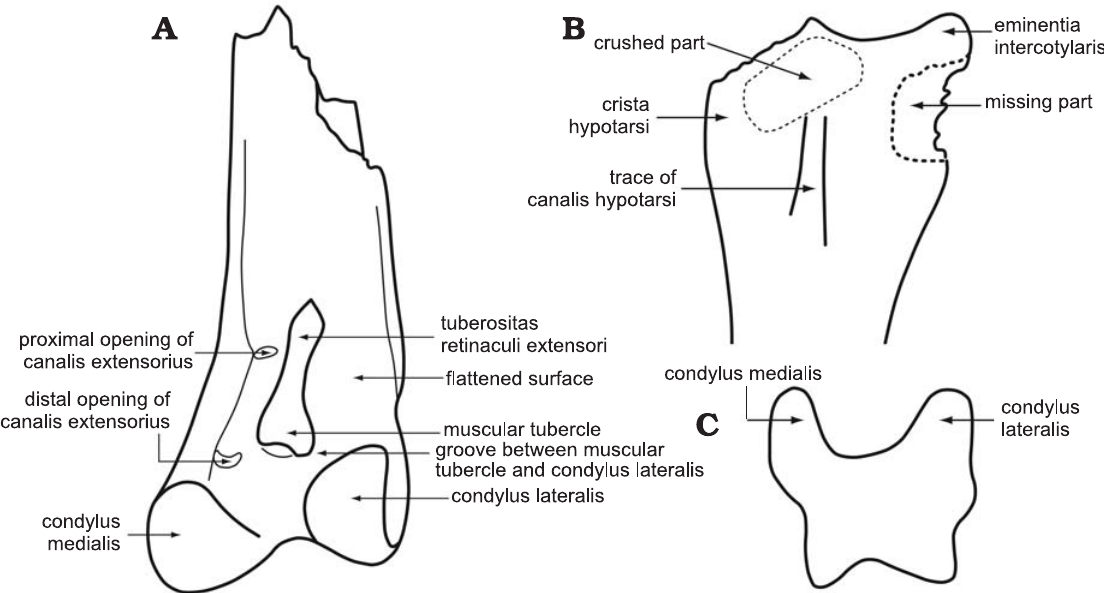
Fig. 7. Diagrams of limb bones of geranoidid bird Galligeranoides boriensis gen. et sp. nov., early Eocene, La Borie, France ( A , B ) and Grus grus (Linnaeus, 1758), extant, Eurasia and Africa ( C ). A . Distal part, cranial view of left tibiotarsus MHNT.PAL.2013.16.3. B . Proximal part, medial view of right tarsometatarsus MHNT.PAL.2013.16.2. C . Distal end of left tibiotarsus, showing the discontinuity in alignment of the condylus